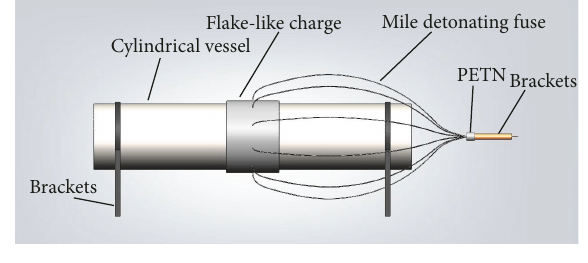
Figure 1: Experiment mode. Table 1: Parameters of